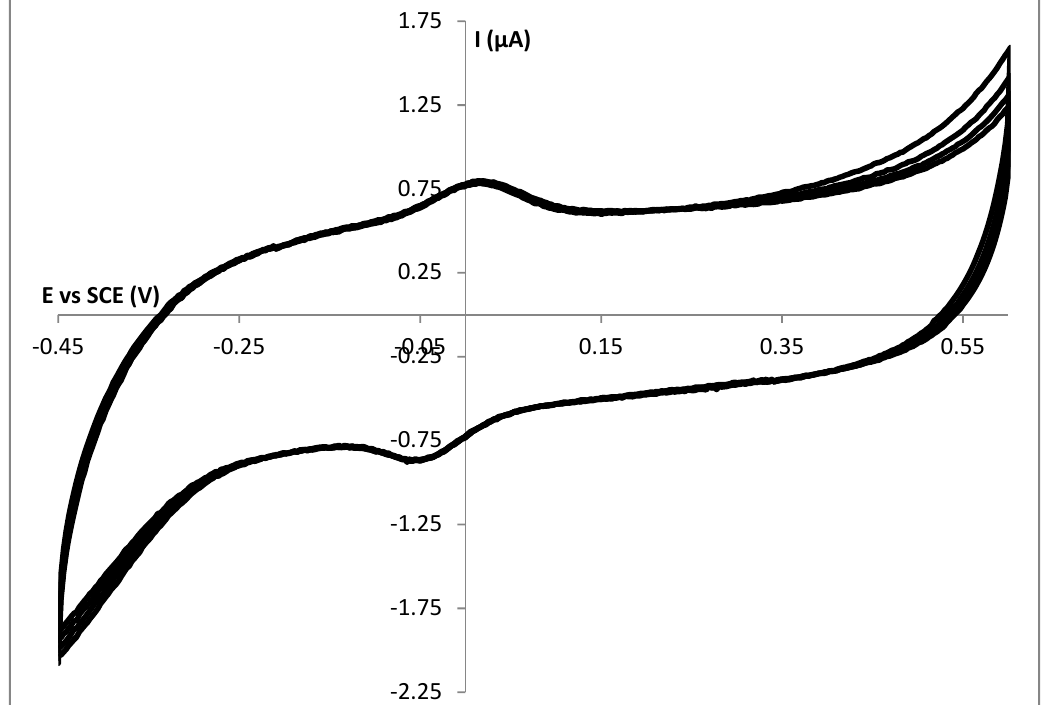
Figure 3. Five successive cyclic voltammograms obtained at a spin coated HHC|GelB|GC electrode in a 10 mmol·L − 1 HEPES pH 7 buffer solution with a scan rate of 50 mV·s − 1